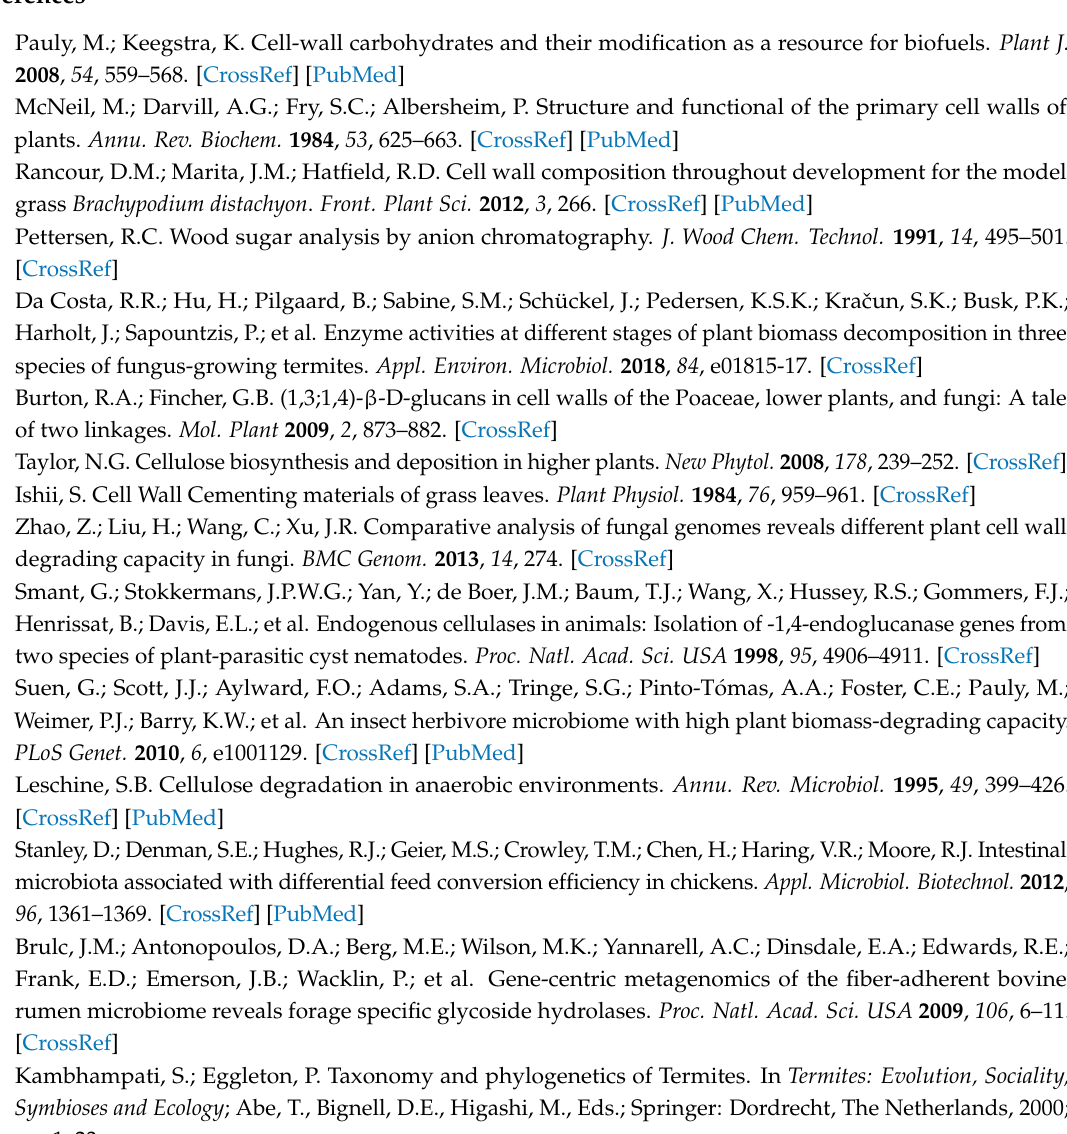
Table S1: Studies that have reported forage substrates in fungus-growing termite species, summarized in Figure 2 of the main text. Species names are given as reported in the respective references. The references Eggleton et al. [1] and Nkunika [2] did not explain what the taxonomical annotations ‘near’ and ‘?’ mean in their